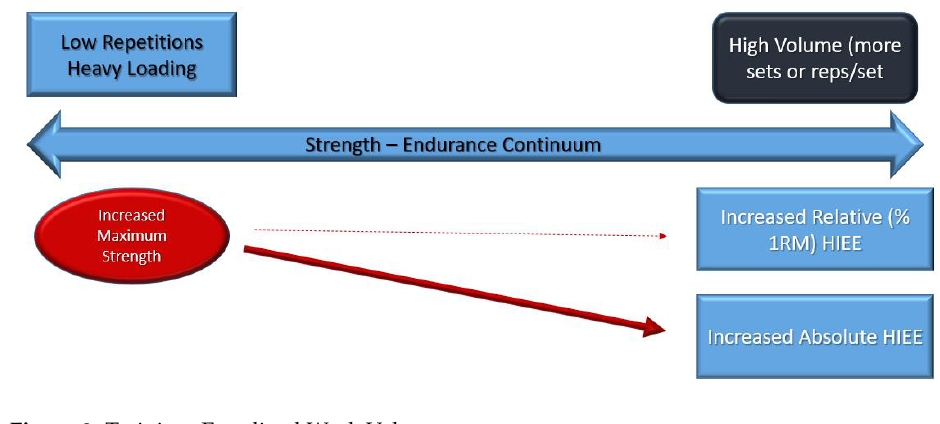
Figure 2. Training: Equalized Work Volume.